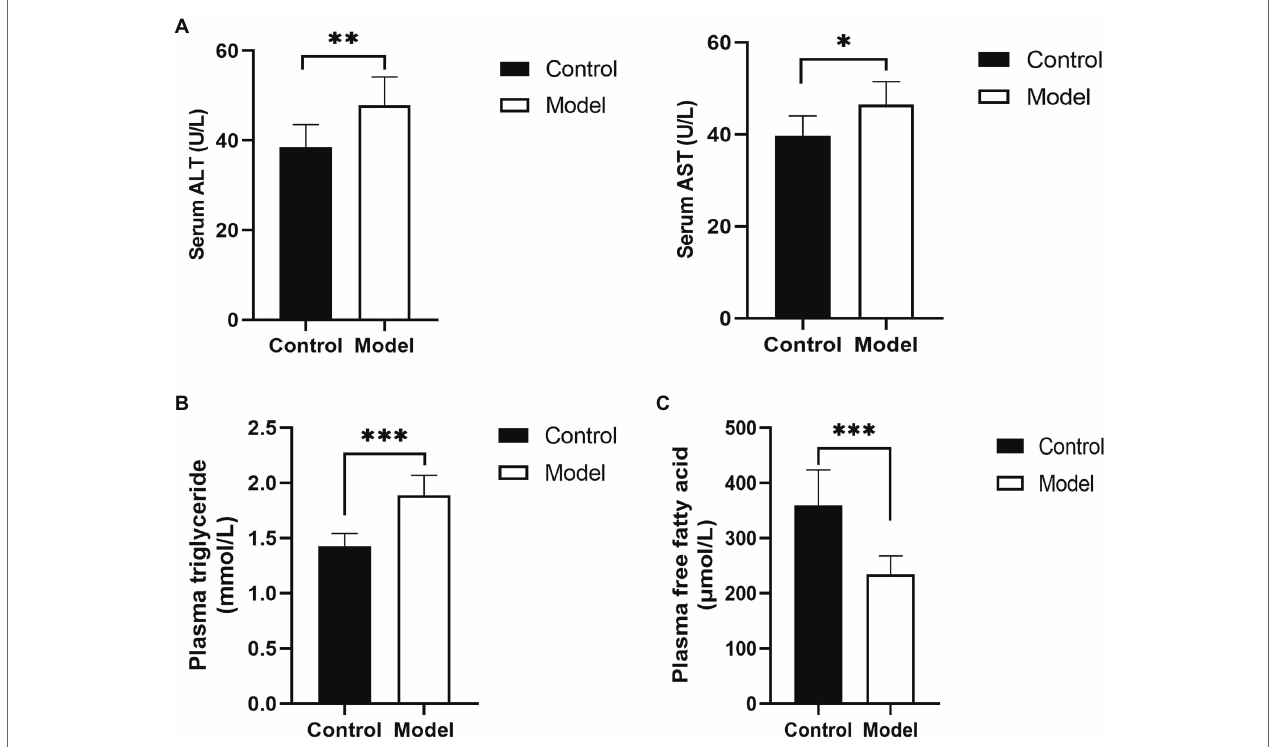
FIGURE 1 | Changes in hepatic function and blood lipids. (A) Serum was analyzed for liver enzyme [aspartate transaminase (ALT) and alanine aminotransferase (AST)] levels; (B) plasma triglyceride levels in insomnia rats were clearly higher than those in controls; and (C) Plasma free fatty acid (FFA) levels in insomnia rats were significantly lower than those in controls. The results were obtained from two independent experiments and are expressed as the mean ± SD, n = 8 per group, * p < 0.05; ** p < 0.01; and *** p <